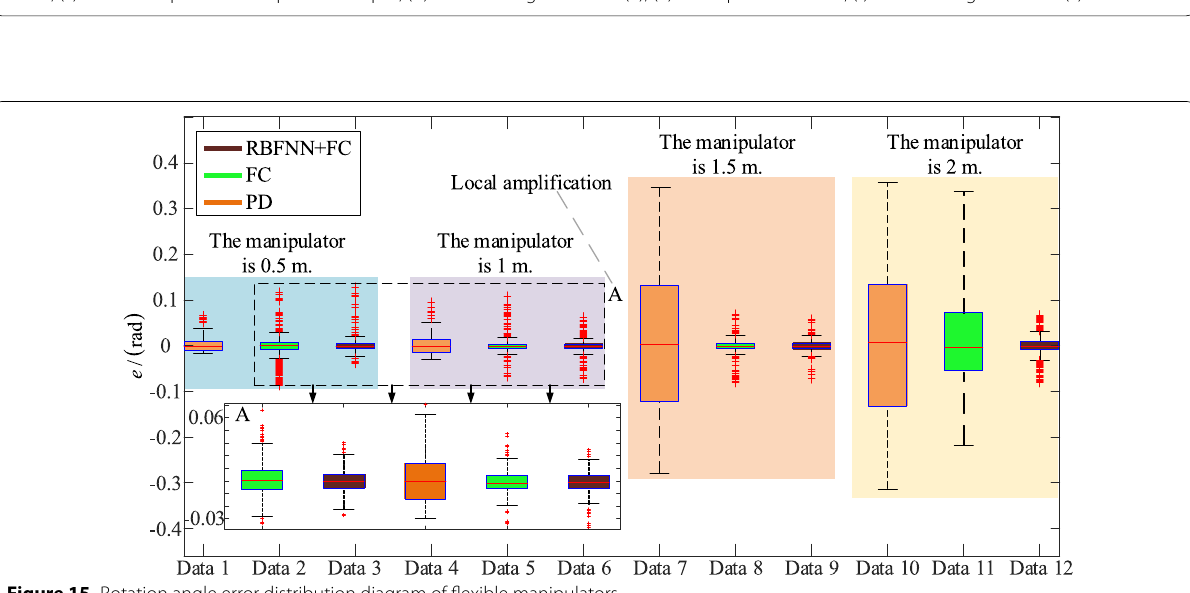
Figure 15 Rotation angle error distribution diagram of flexible